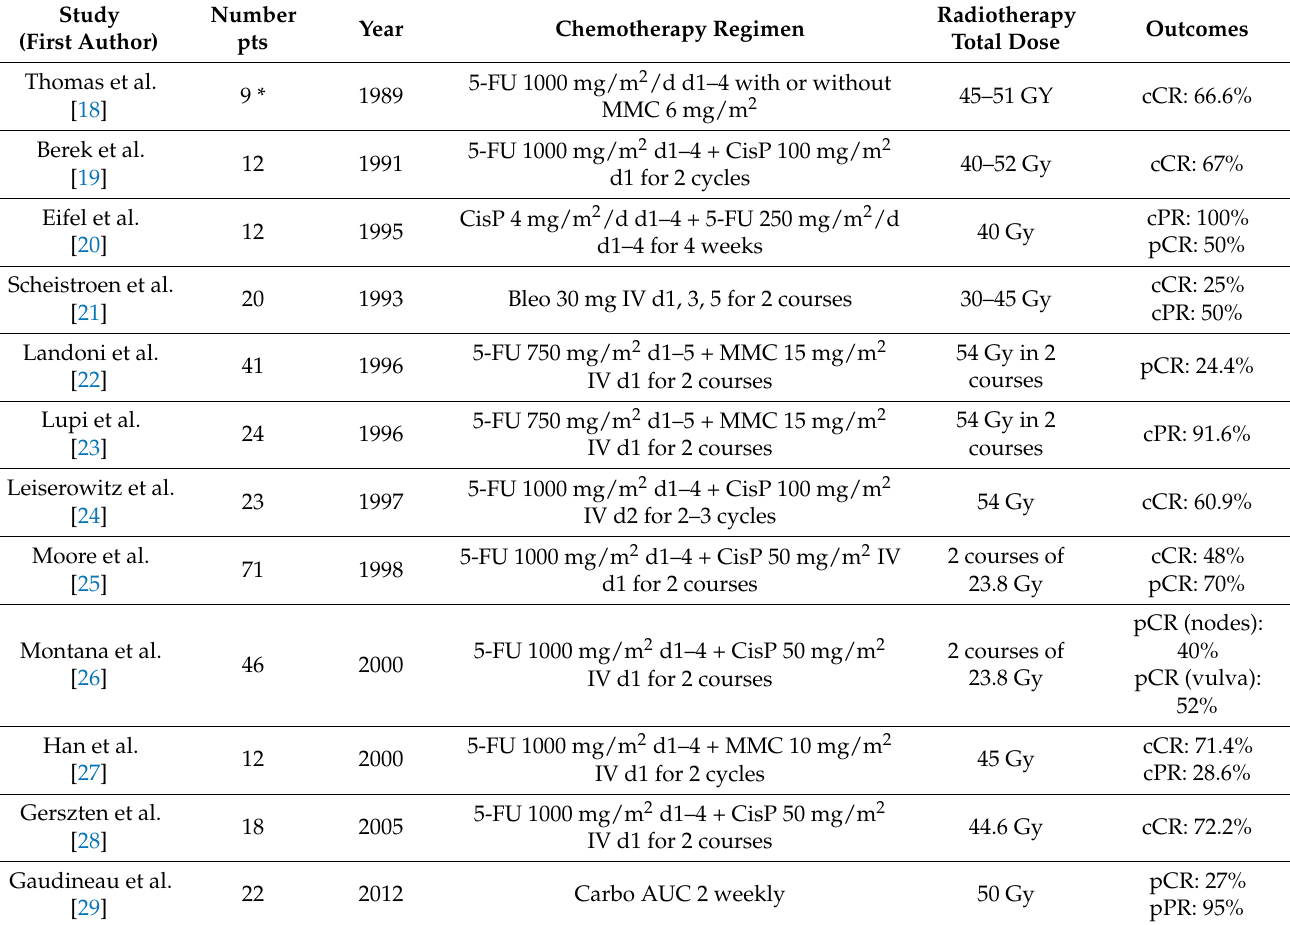
Table 1. Summary of studies with more than 10 patients exploring neoadjuvant chemoradiation in locally advanced vulvar